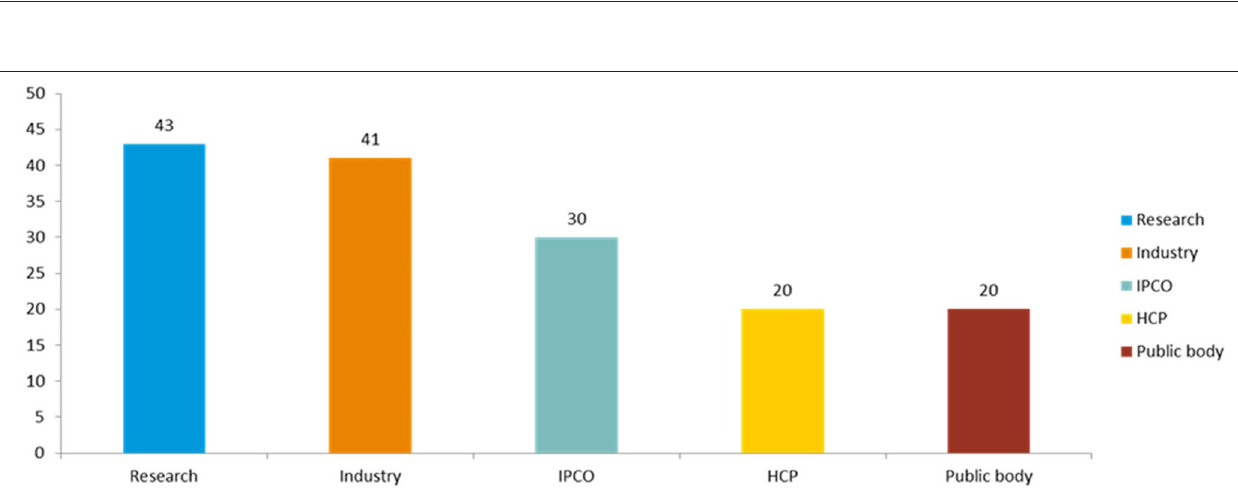
FIGURE 2 | Number of responses received to the public consultation by stakeholder